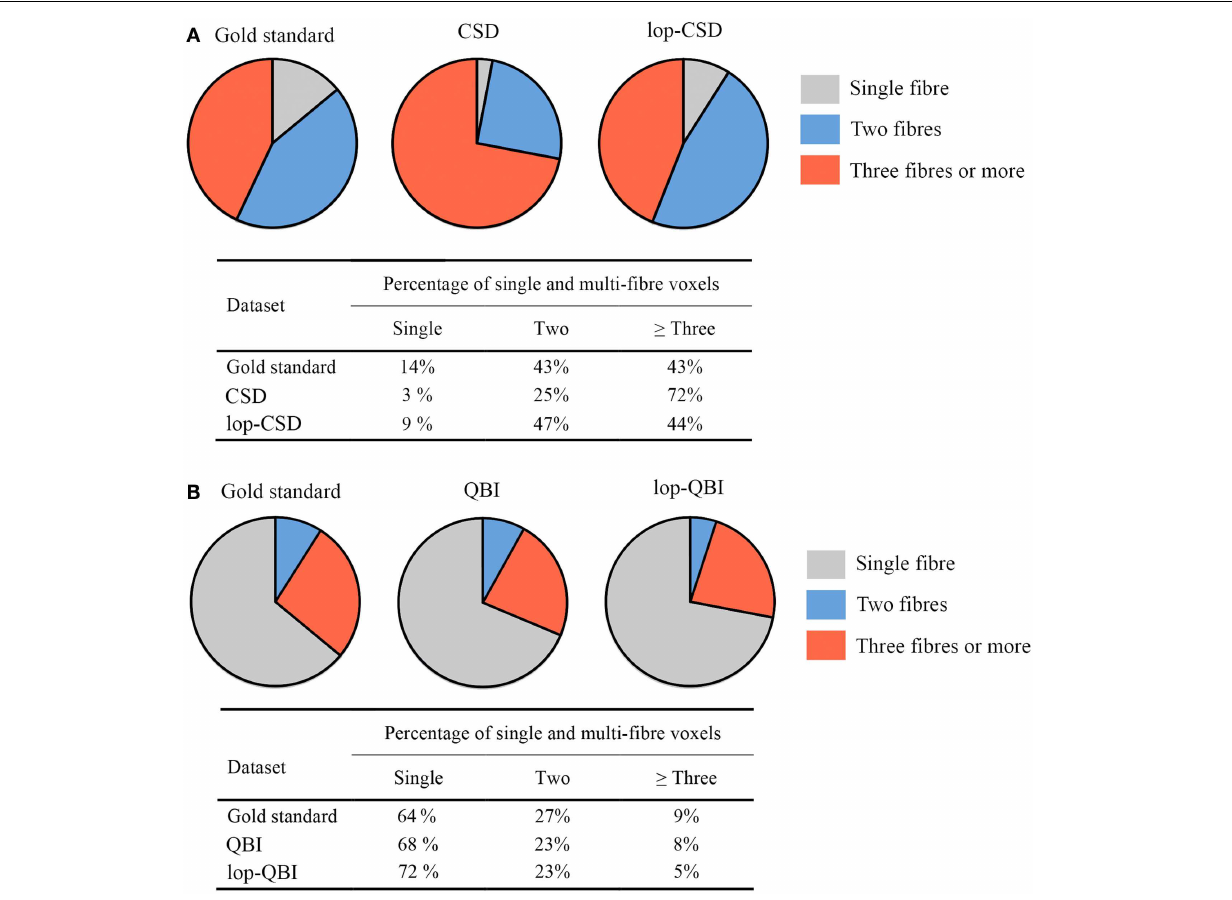
FIGURE 9 | Fiber population count across voxels of the white matter, (A,B) percentages of voxels with single, two, or greater than three fiber populations across the whole white matter, estimated for gold standard (see Method), raw–DWI, and lop-DWI, using (A) CSD, and (B) QBI techniques